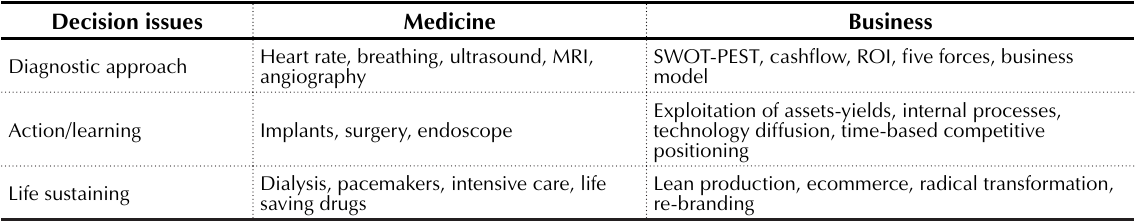
Table 3. Two contrasts of knowledge tool kits: medicine and